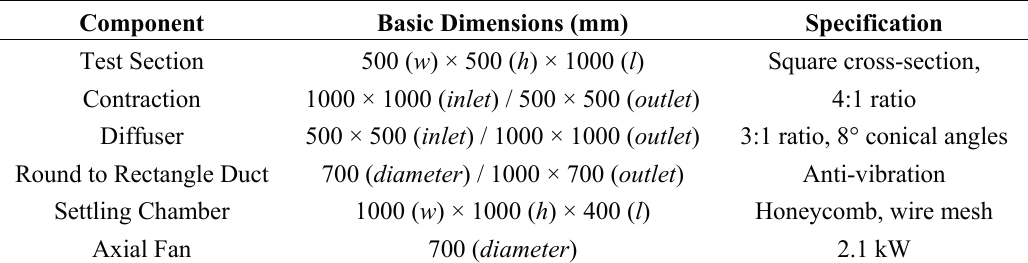
Figure 2. Schematic representation of the heating elements inside the duct. Table 1. Summary of the design specification and dimensions of wind tunnel